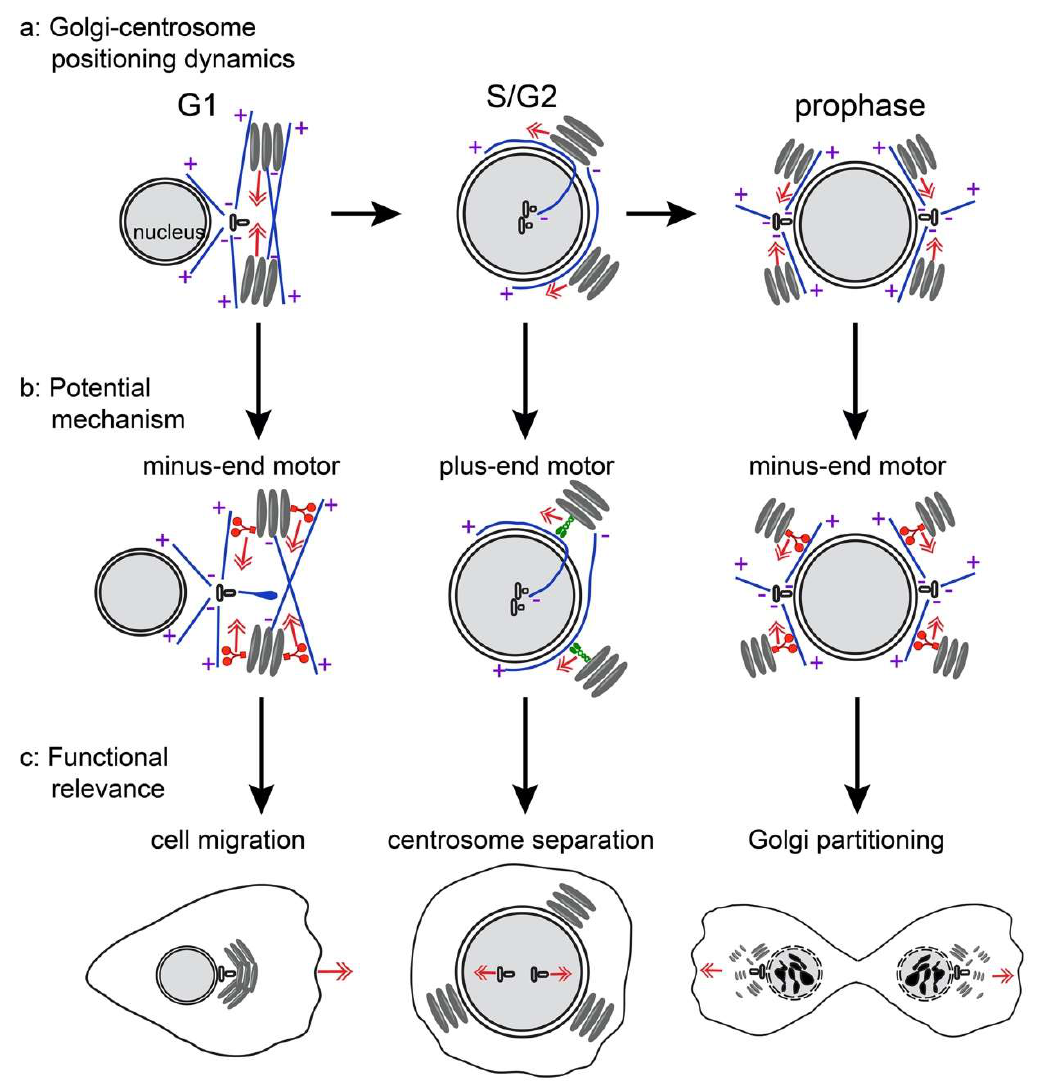
Figure 7. Model of Golgi-centrosome relationships throughout the cell cycle. ( a ) Golgi and centrosome association and positioning in G1 (C1 mode, left), S / G2 (E mode, center), and prophase (C2 mode, right). Both centrosomal and Golgi-derived MTs serve as tracks for Golgi movement. ( b ) Proposed mechanism driving Golgi configuration in the stages according to those depicted in ( a ). Because the centrosomal MT aster is dispensable for the Golgi configuration, it is likely that switches in molecular motor activity are involved. Minus end directed motor activity prevails in compact Golgi modes ( b , left and right). Plus end directed motor transport along peri-nuclear MTs prevails during E mode ( b , center). ( c ) Cellular functions that correlate with Golgi configuration modes depicted in ( a ), based on our findings and the literature. Compact Golgi in G1 supports cell polarity and migration ( c , left). Detachment of the centrosome from the Golgi in E mode allows for the pre-mitotic centrosome separation ( c , center). Concentration of Golgi fragments at the mitotic poles support e ffi cient Golgi partitioning during cell division ( c , right).